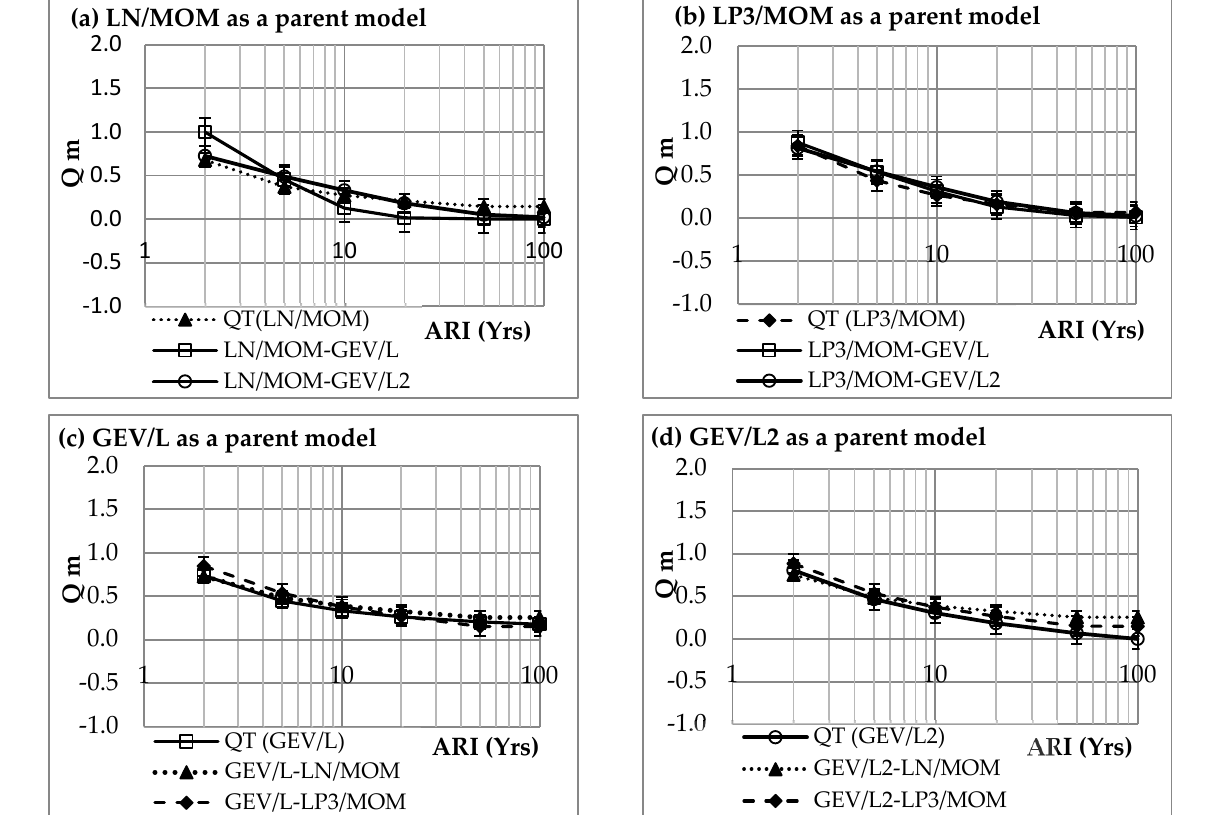
Figure 3. Comparison of the 7-day mean quantile estimate (Q m ) of catchment A5030526 (wet catchment) at Uraidla when data generated from another model. Error bars indicate standard error.